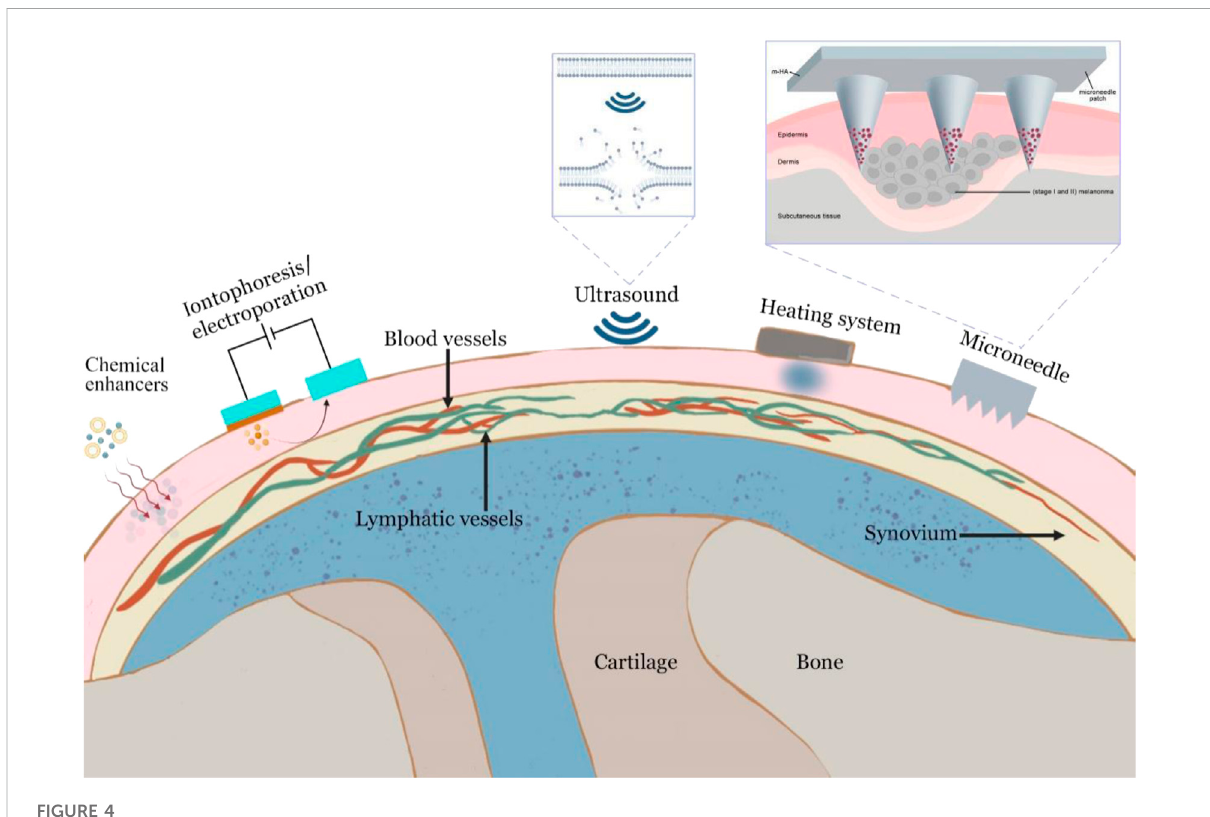
FIGURE 4 Skin penetration enhancement